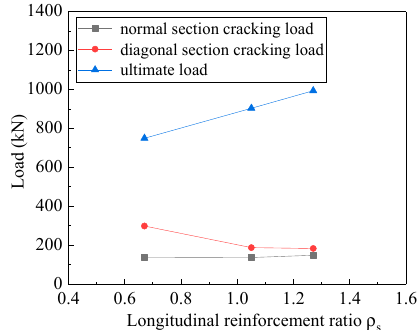
Figure 12. Relation curve between ρ s and load.